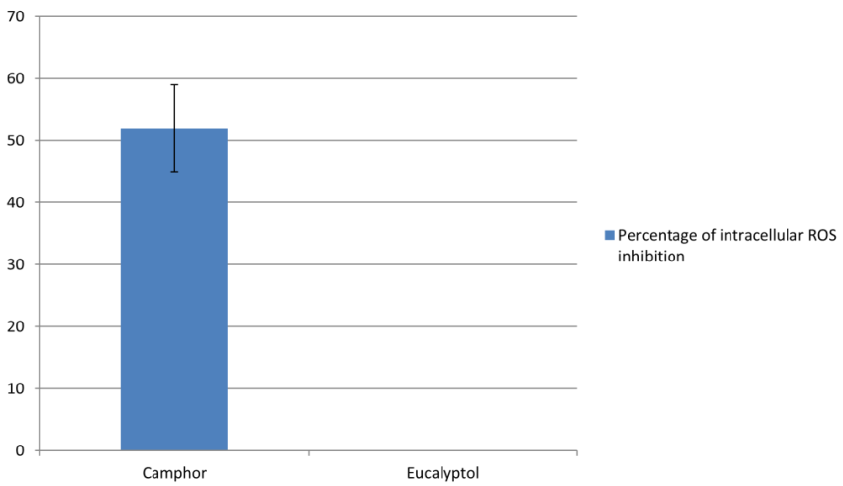
Figure 4. Percentage of inhibition of reactive oxygen species in Candida albicans cells treated with camphor and eucalyptol (no activity). Values represent means ± SD of three replicates.